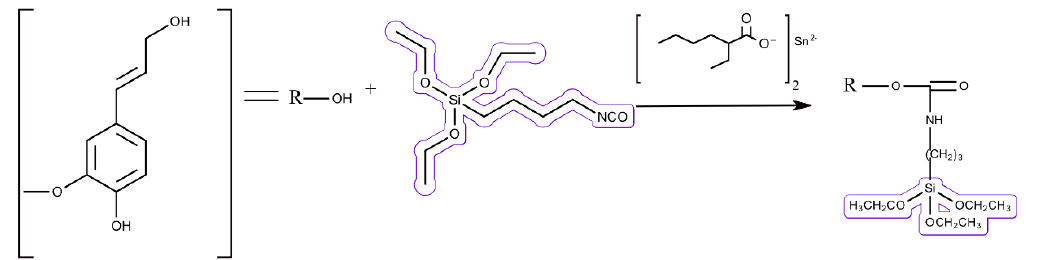
Figure 11. Reaction mechanism of lignin with (triethoxysilyl)propyl isocyanate in order to improve the combability with rubber (adapted from [247]).